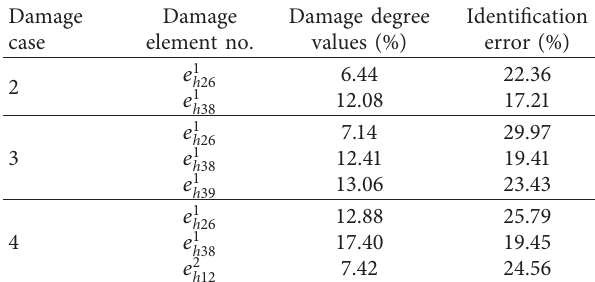
Figure 9: Calculation results of damage degree of hinge joints for case study 4. Table 2: Damage degree values for multipoint damage case studies.